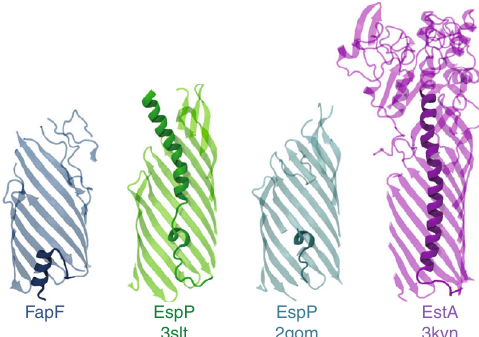
Fig. 7 Structural comparison to the Type Va autotransporter (AT) family. The backbone root-mean-square deviation (RMSD) of FapF is below 4 Å for overlay of FapF with each of the transporter domains. EspP has been solved as the full-length pre-processed protein (3slt, green ) and the processed, autocatalytically cleaved form (2qom, teal ). EstA is another full-length AT with a lipase domain on the extracellular face (3kvn, magenta ). The plug domains are shown as cartoons with backbones transparent and cutaway for